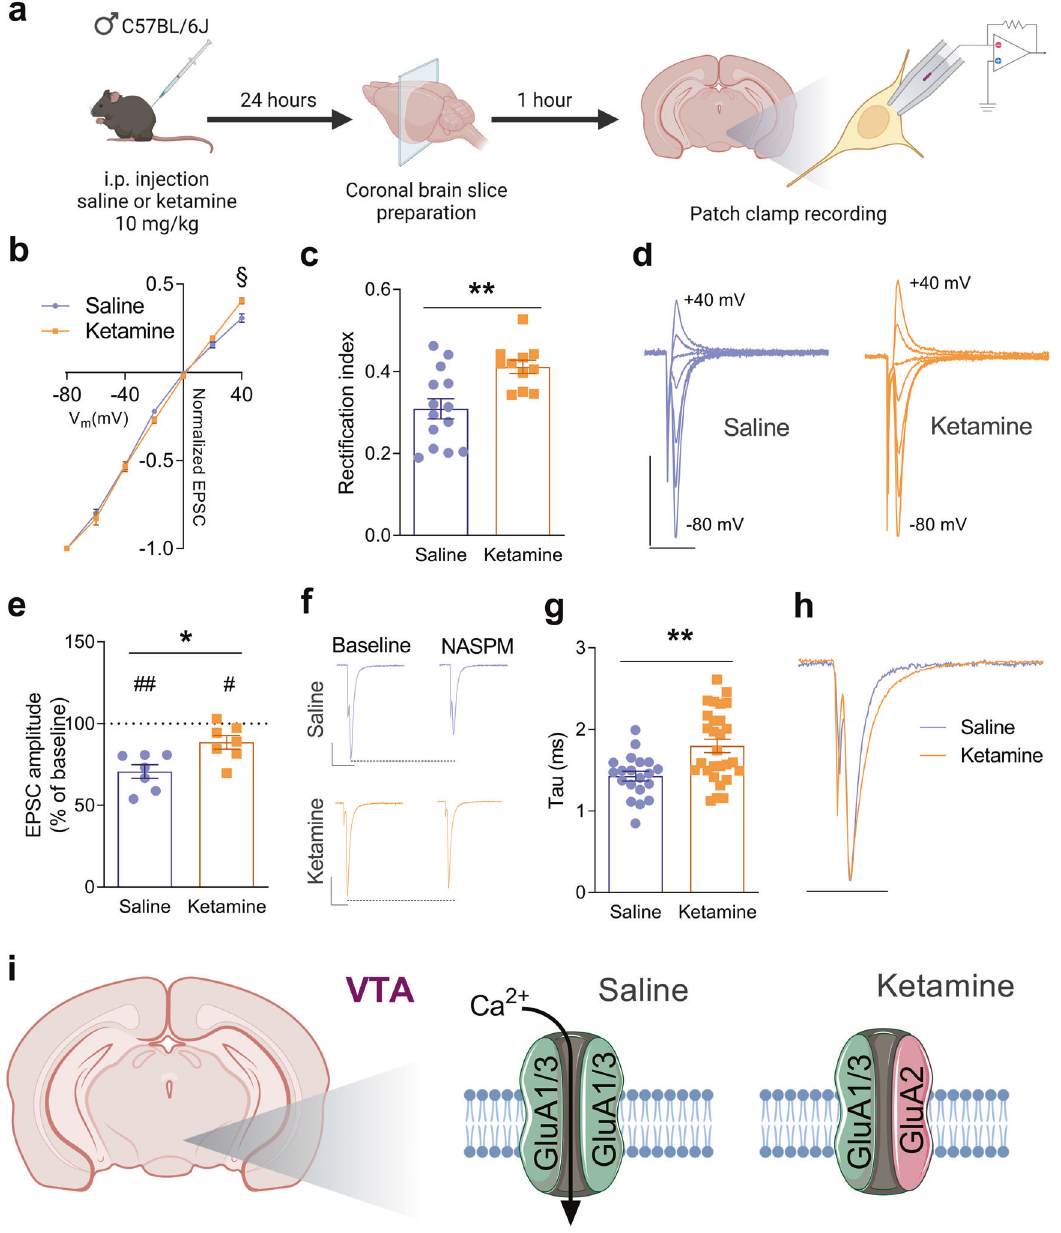
Fig. 1 Ketamine promotes the insertion of calcium impermeable AMPARs at glutamatergic synapses onto VTA DA neurons. a Schema illustrating the experimental design. b I/V relationships of AMPAR-EPSCs amplitude normalized by − 80mV in VTA DA neurons from saline- and ketamine-treated mice. § P = 0.0262, two-way ANOVA. c Recti fi cation index from the neurons in ( a ) Saline: 0.31 ± 0.025 ( n = 14 neurons from 4 mice), ketamine: 0.41 ± 0.016 ( n = 11 neurons from 5 mice). ** P = 0.0032 unpaired t -test. d Example traces of AMPAR-EPSCs recorded at holding potentials between − 80 mV and + 40 mV with 20 mV increments in a VTA DA neuron from a saline-treated mouse and in a VTA DA neuron from a ketamine-treated mouse. Scale bars represent 200 pA and 10 ms for both neurons. e Effect of bath application of NASPM (25 μ M), a GluA2-lacking CP-AMPAR blocker; % of baseline in saline-treated mice: 70.67 ± 4.2 ( n = 7 neurons from 4 mice), and in ketamine- treated mice: 88.56 ± 4.2 ( n = 7 neurons from 4 mice). * P = 0.0107 unpaired t -test. # P = 0.0317, ## P = 0.001 paired t -test. f Example traces of AMPAR-EPSCs before (baseline) and during the application of NASPM in the perfusion solution in a VTA DA neuron from a saline-treated mouse and in a VTA DA neuron from a ketamine-treated mouse. Scale bars represent 100 pA and 10 ms for both neurons. g AMPAR-EPSC tau (ms) in saline-treated mice: 1.43 ± 0.06 ( n = 20 neurons from 7 mice), and in ketamine-treated mice: 1.8 ± 0.08 ( n = 28 neurons from 10 mice). ** P = 0.0014 unpaired t -test. h Superimposed AMPAR-EPSCs traces illustrating the slower kinetics in a VTA DA neuron from a ketamine-treated mouse compared to that recorded in a VTA DA neuron from a saline-treated mouse. Scale bar represents 10 ms for both neurons. i Schema summarizing the effect of ketamine on the involvement of GluA2 in synaptic AMPARs in VTA DA